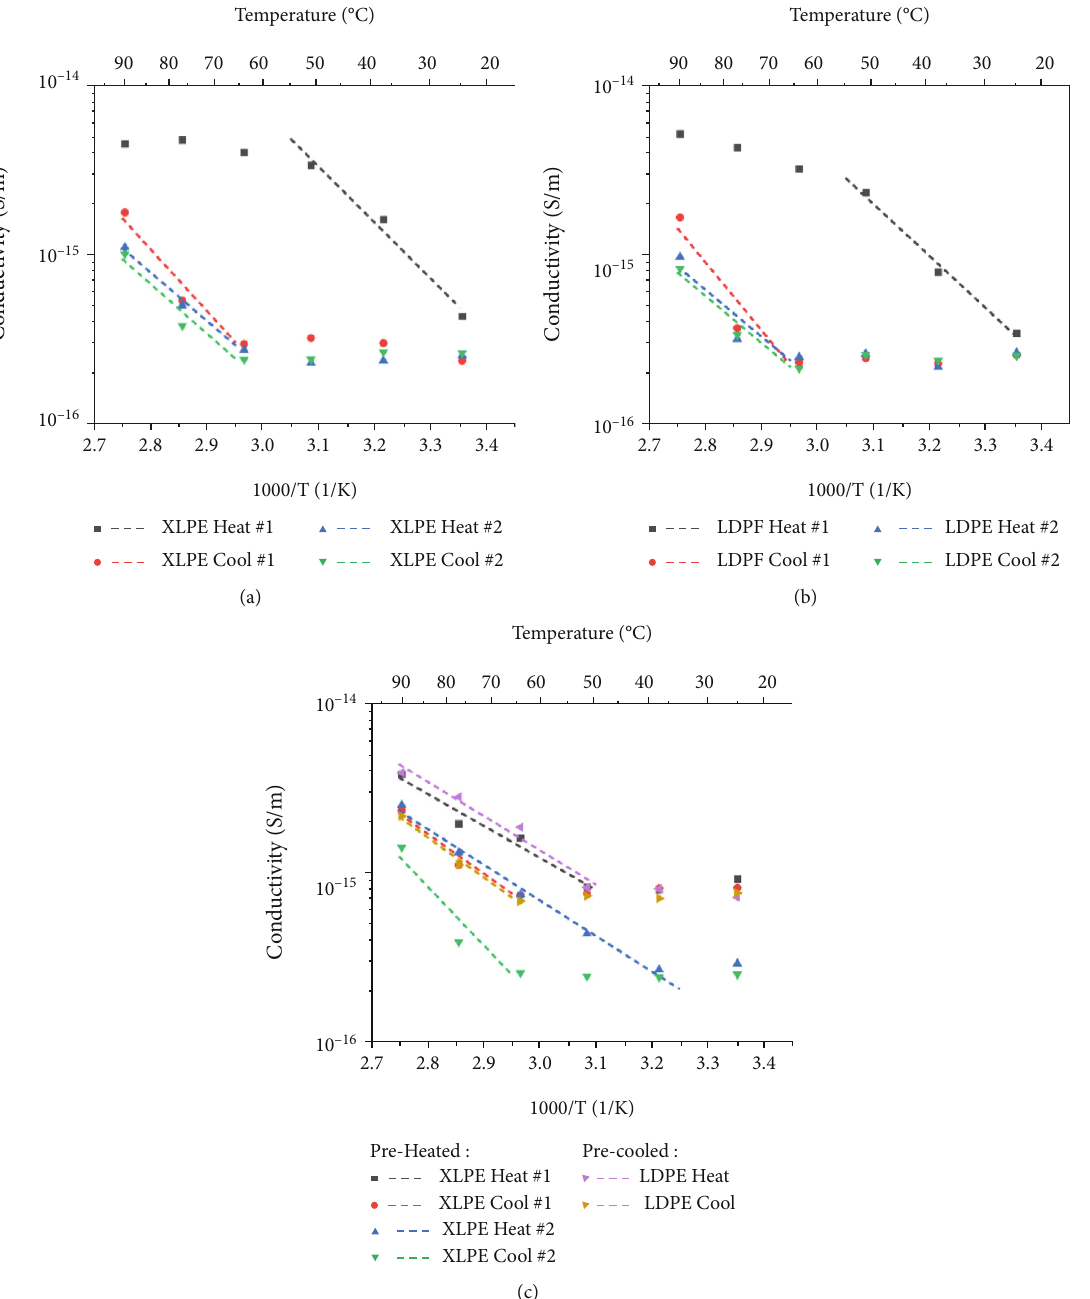
Figure 8: Repeated temperature-dependent conductivity measurements for degassed (a) XLPE and (b) LDPE. In part (c), the loops for XLPE and LDPE were preceded by either heating from 25 ° C to 90 ° C or cooling down from 90 ° C to 25 ° C the sample in the oven with no electrical fi eld